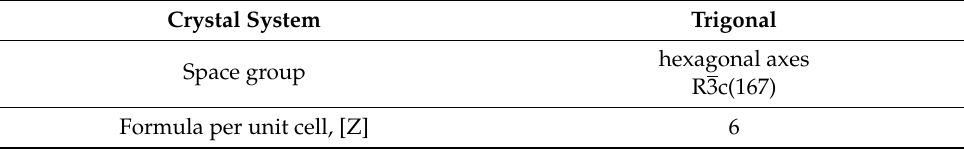
Figure 1. Structures of AlH 3 polymorphs of α − AlH 3 , α (cid:48) − AlH 3 , β − AlH 3 , γ − AlH 3 . Reprinted with permission from Ref. [10]. Copyright 2009 Elsevier. Table 1. Crystallographic data of α − AlH 3 [28]. Cited from Ref. [28] with